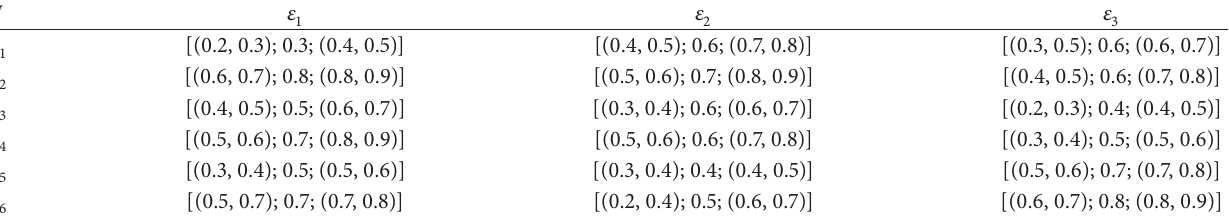
Table 2: An interval-valued triangular fuzzy soft set (𝐺,𝐵)